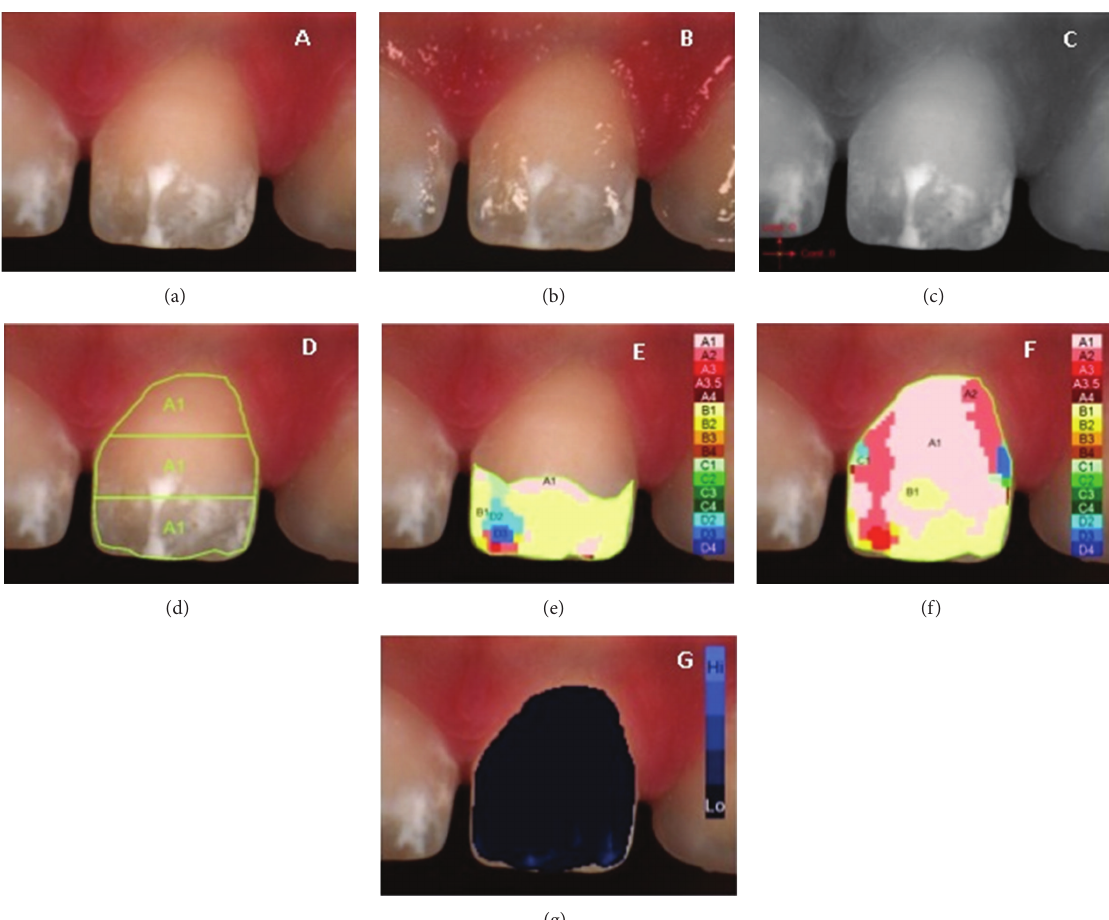
Figure 5: Example of 𝐿 ∗ 𝑎 ∗ 𝑏 ∗ measurements of diffused opacity on upper central incisor: (a) polarized image; (b) gloss mode allowing the identification of “pure enamel zones”; (c) contrast image; (d) evaluation of the three equal zones along the median axis: gingival, central, and incisal; (e) colour distribution and detailed mapping of the defect surface; (f) overall detailed mapping; (g)